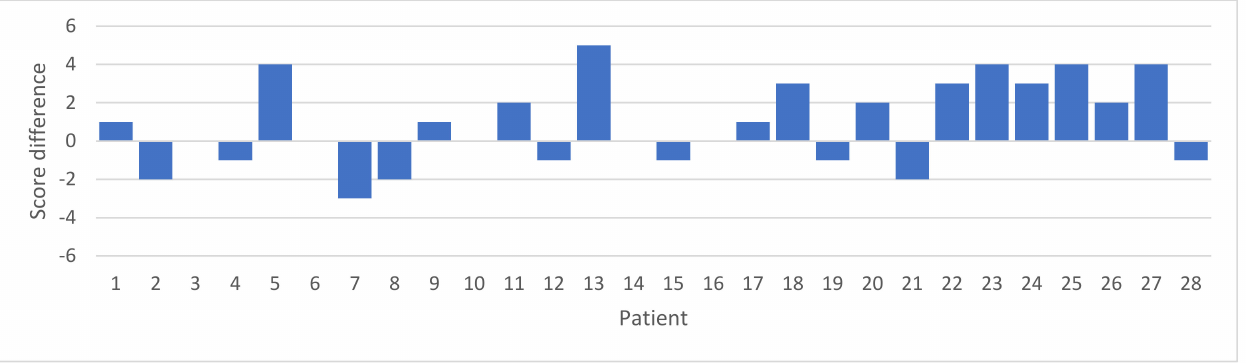
Figure 5. Lung score difference between the algorithm and the expert.